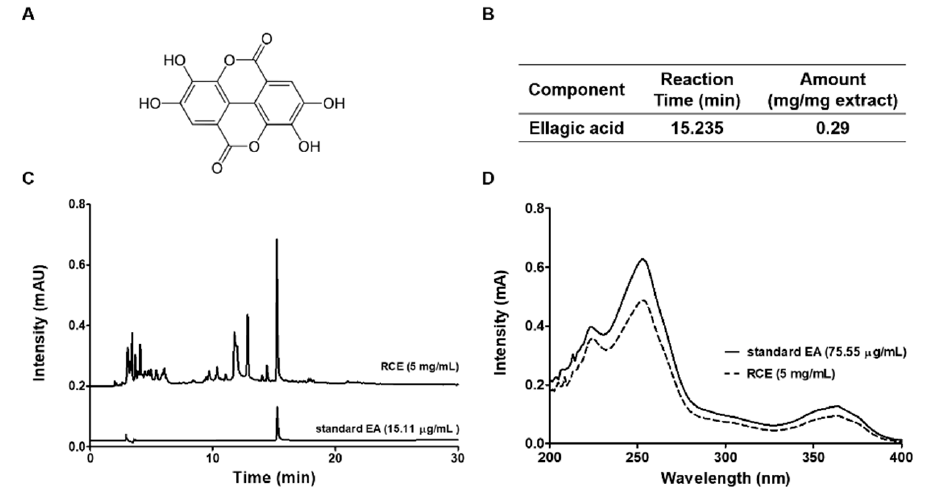
Figure 3. Identification of the main compound of RCE by HPLC analysis. ( A ) Structures of the major compound of RCE. ( B ) The amount of ellagic acid in RCE and retention time. ( C ) High-performance liquid chromatography (HPLC) profiles of ellagic acid from RCE. ( D ) Standard ellagic acid was used for reference compound and monitored at 254 nm.